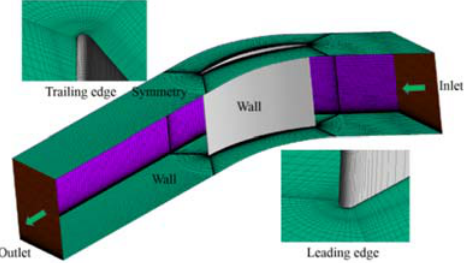
Figure 1. The NACA65-K48 grid structure.